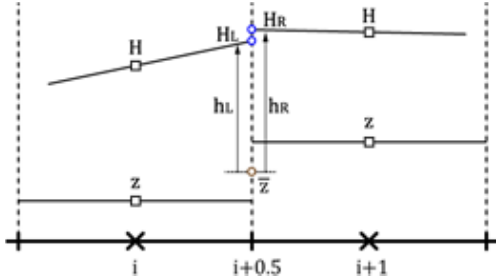
Figure 2. Reconstructed water depth h L , R for inundation (LeVeque and George,